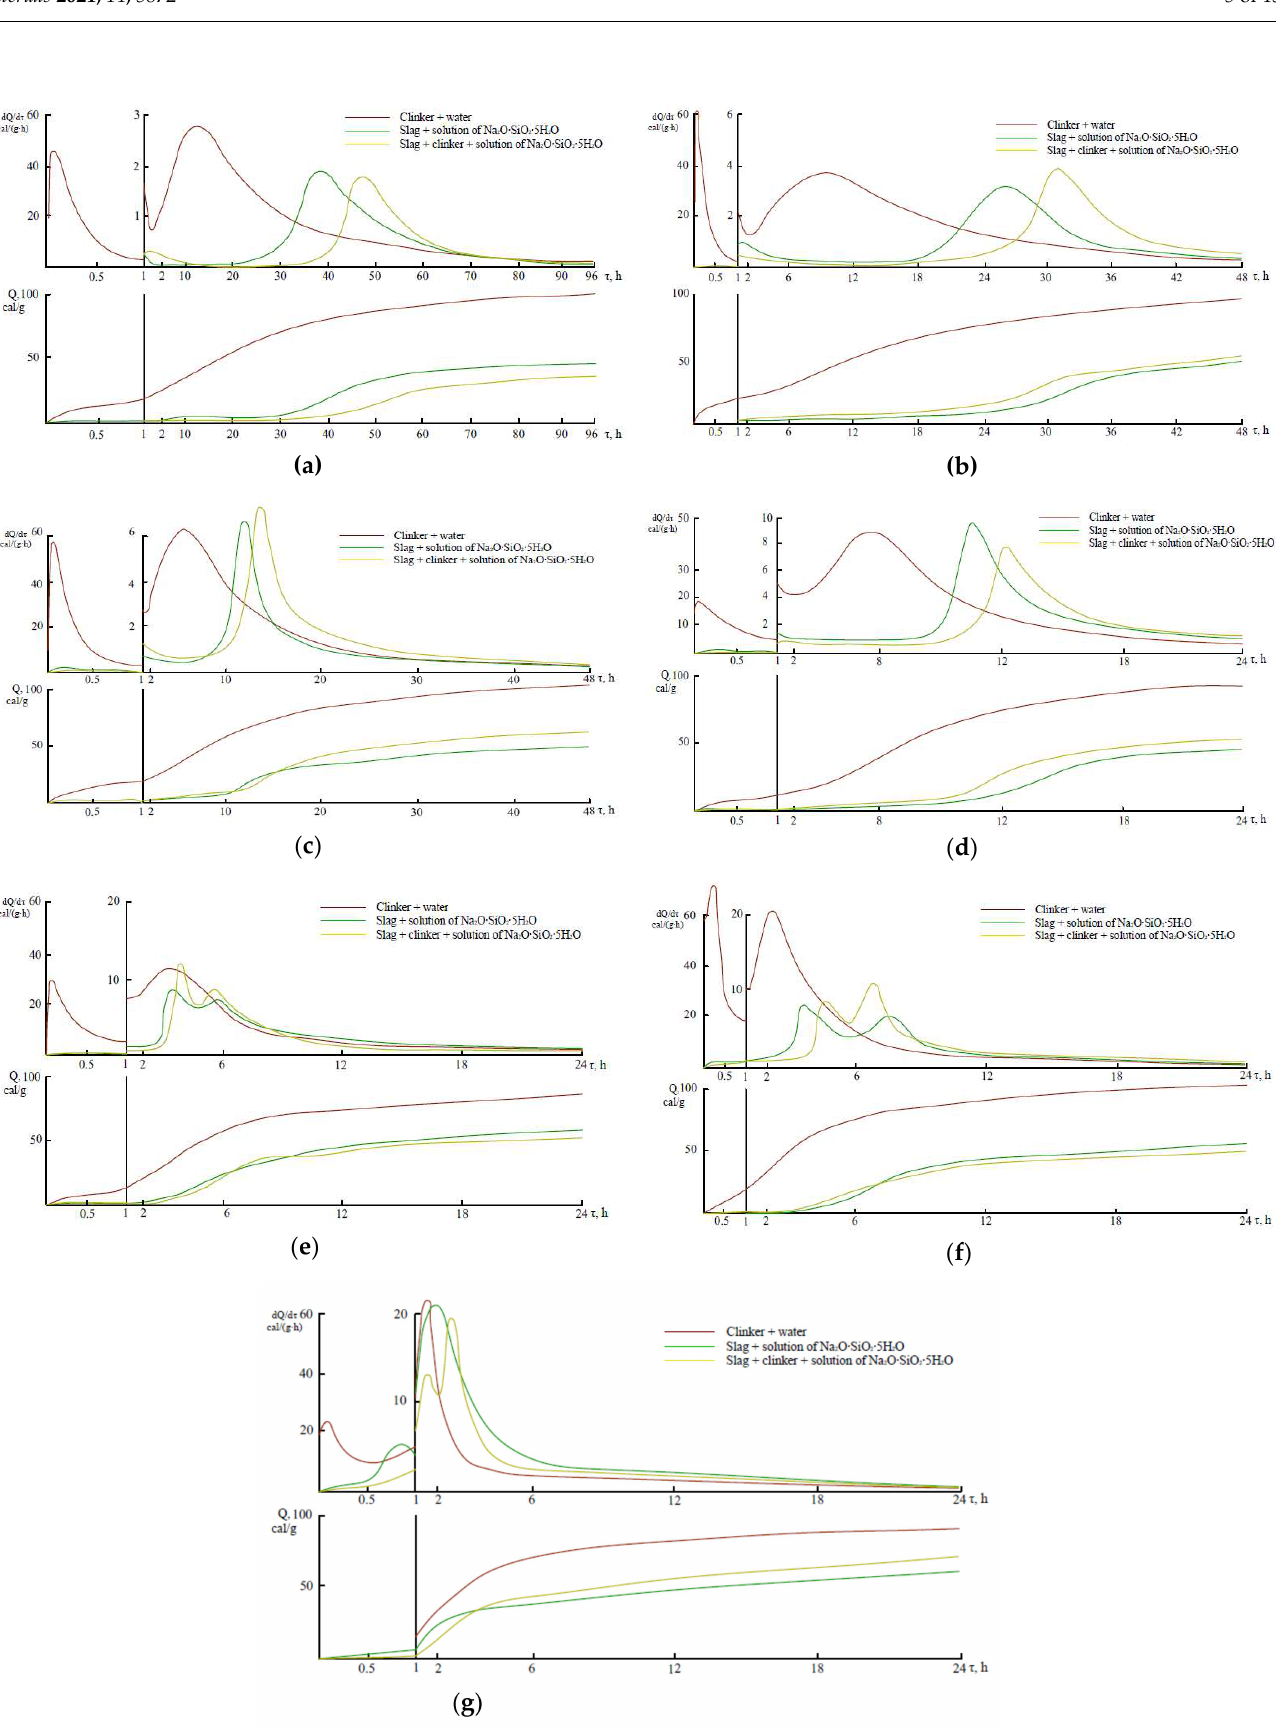
Figure 2. The thermokinetic characteristics of cements hydration process at temperatures of 20 ◦ C ( a ); 30 ◦ C ( b ); 40 ◦ C ( c ); 50 ◦ C ( d ); 60 ◦ C ( e ); 70 ◦ C( f ); 80 ◦ C ( g